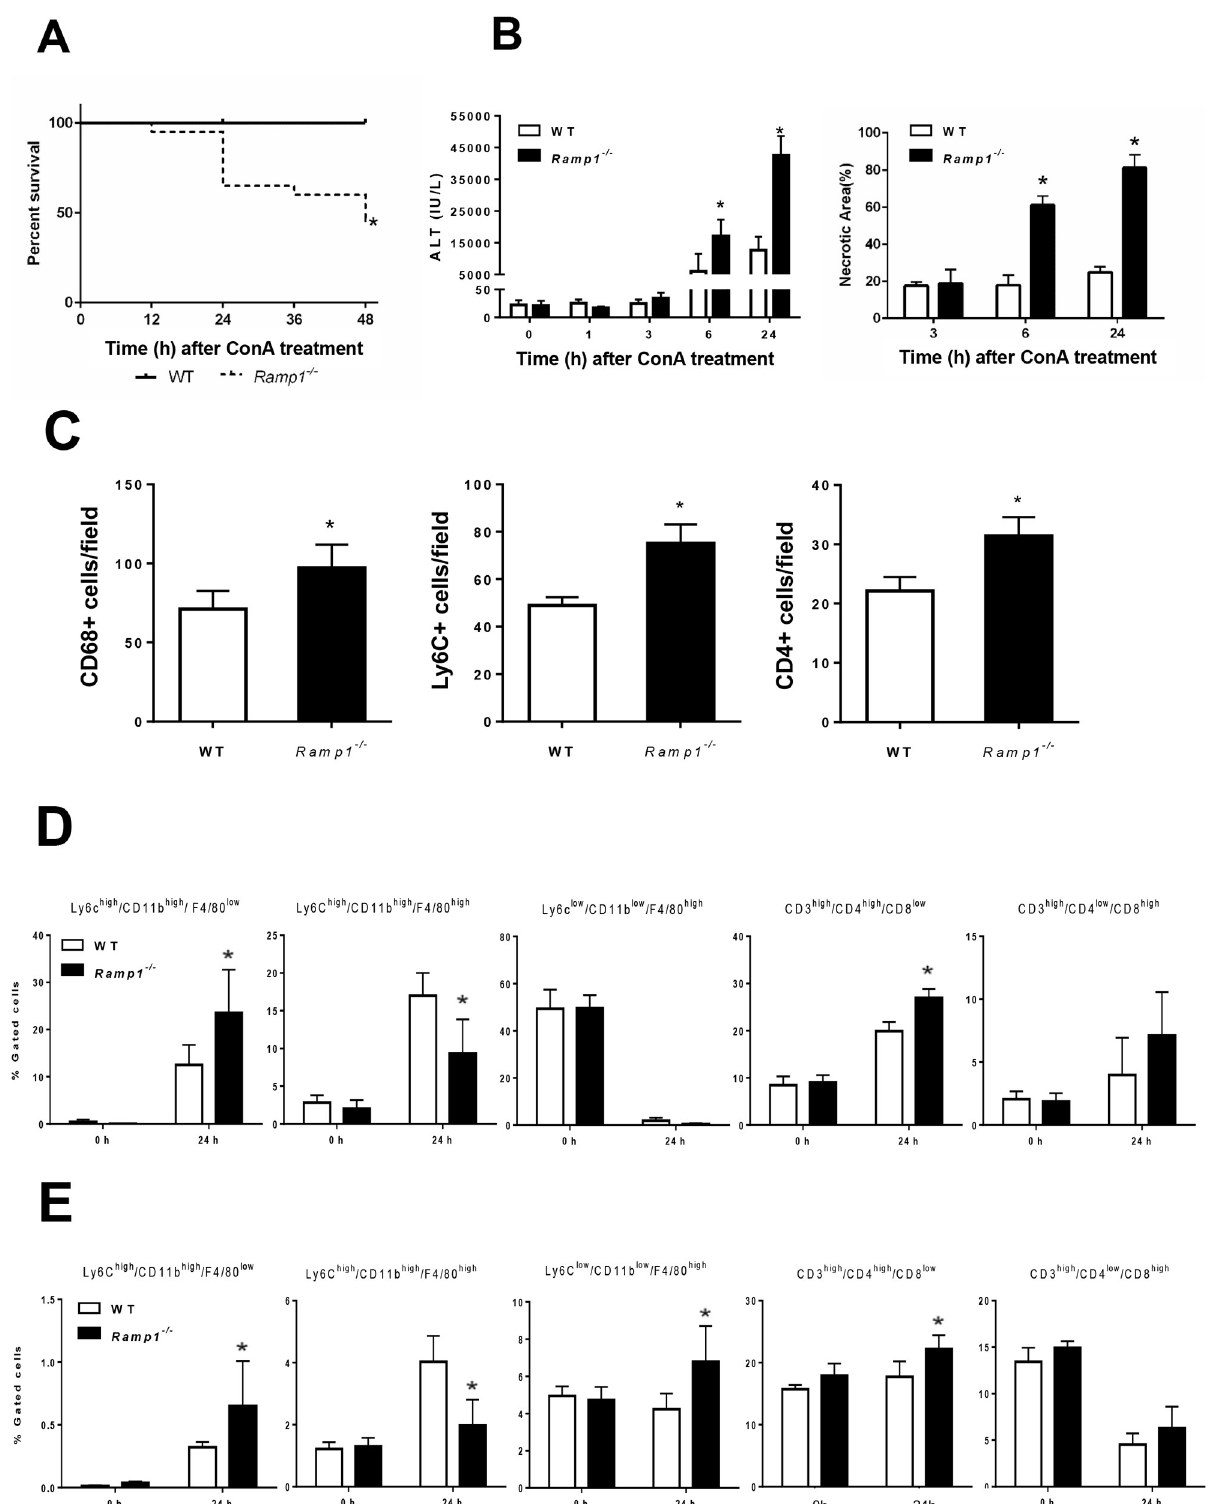
Fig 1. Deficient RAMP1 signaling exacerbates ConA-induced liver injury via infiltration of inflammatory cells into the liver. Ramp1 -/- and WT mice were administered ConA (20 mg/kg) by intraperitoneal (i.p.) injection. (A) Kaplan-Meier survival curves for Ramp1 -/- mice (n = 20) and WT mice